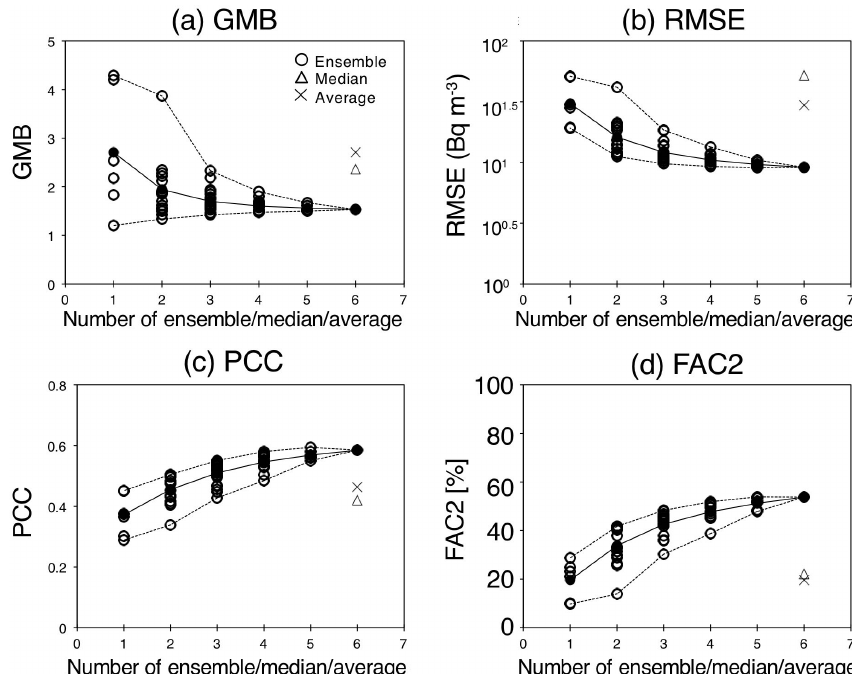
Figure 10. Statistical metrics (GMB, RMSE, PCC and FAC2) at the available sites against the number of the ensemble members, the median and the average ( x axis). The black line indicates an average of the ensemble results for each number, whereas the dashed line indicates the maximum and minimum results of the ensemble results for each